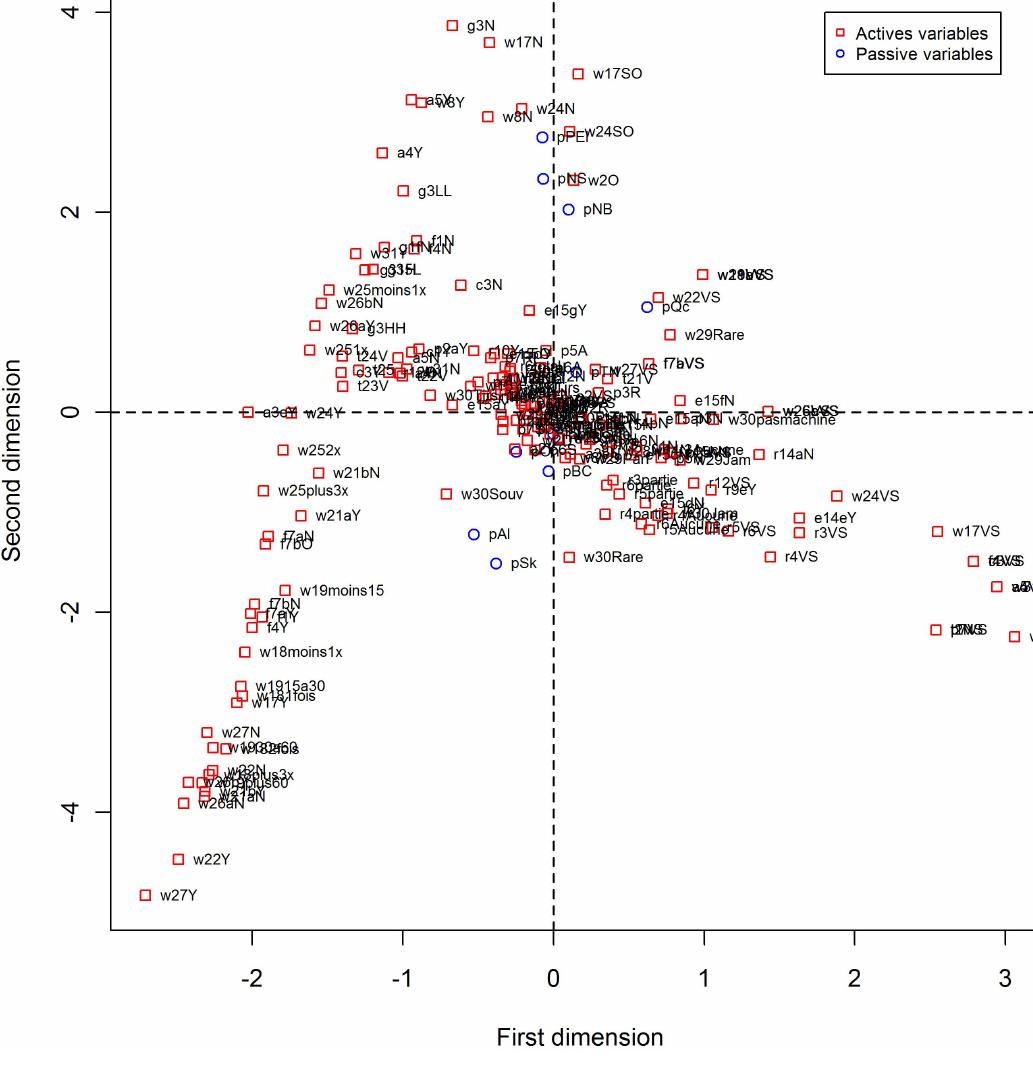
Figure 2. Map representation of the MCA results on the 55 questions without extreme responses.